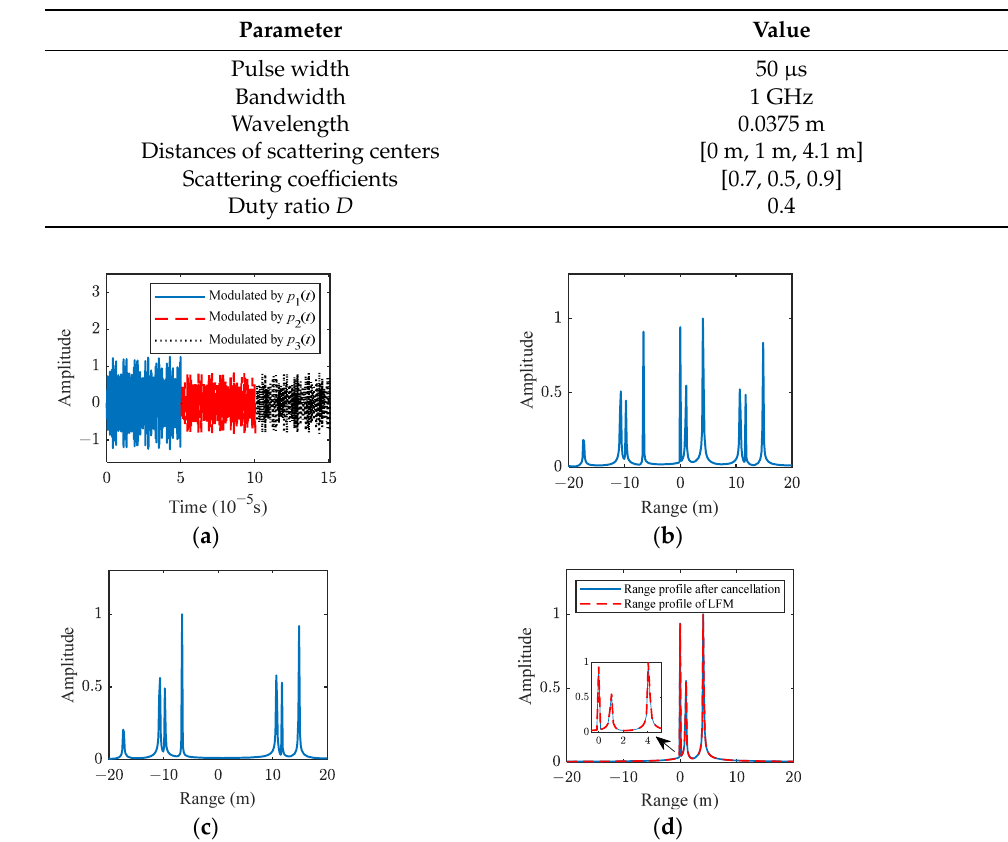
Table 1. Parameters of range profile simulation.